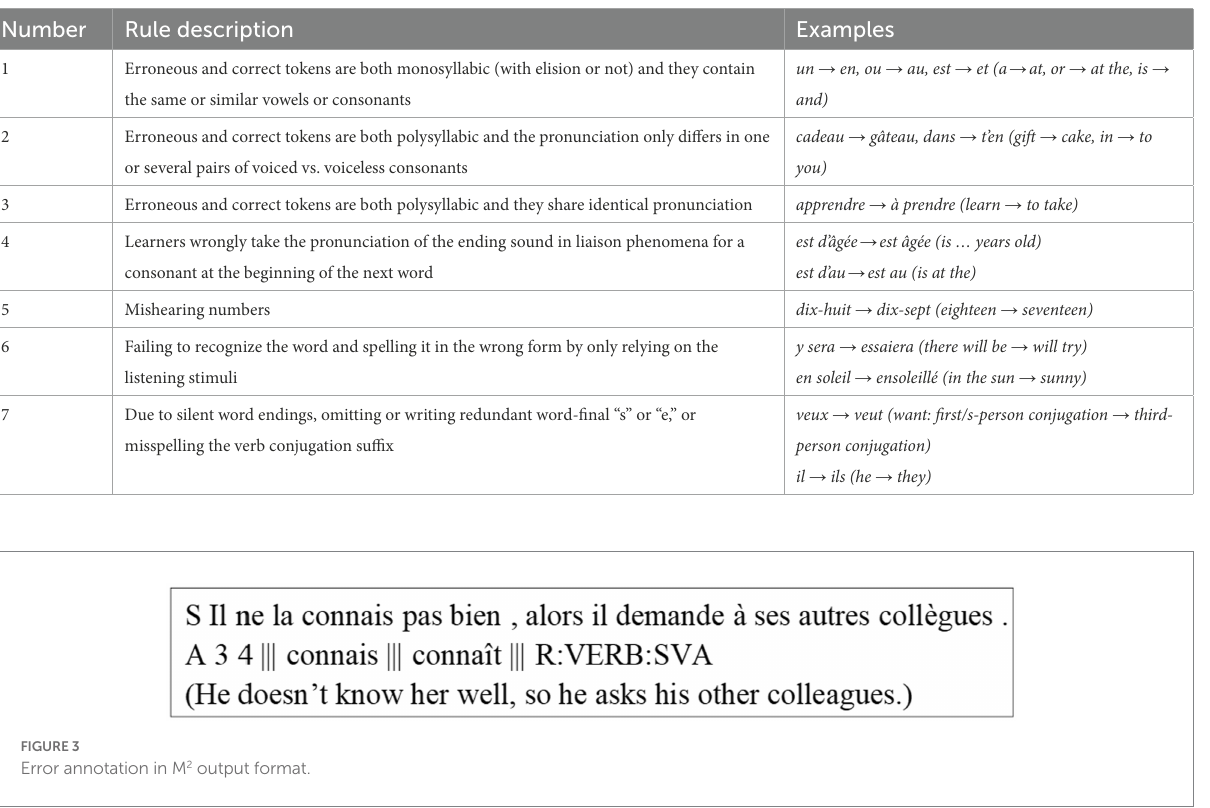
TABLE 3 Rules and examples for phonetic error classification.